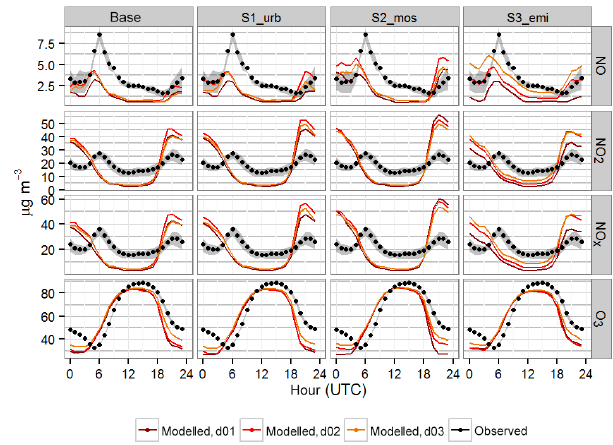
Figure 11. Mean diurnal cycles of NO, NO 2 , NO x and O 3 for all Berlin and Potsdam urban background stations as observed and modelled by the base run, S1_urb, S2_mos and S3_emi. Model re- sults are given for all three model domains (d01 – 15km horizontal resolution, d02 – 3km, d03 – 1km). The diurnal cycle is averaged over six stations for NO, NO 2 and NO x and three stations of O 3 . The grey shaded areas represent the variability between the differ- ent stations’ diurnal cycles, showing the 25th and 75th